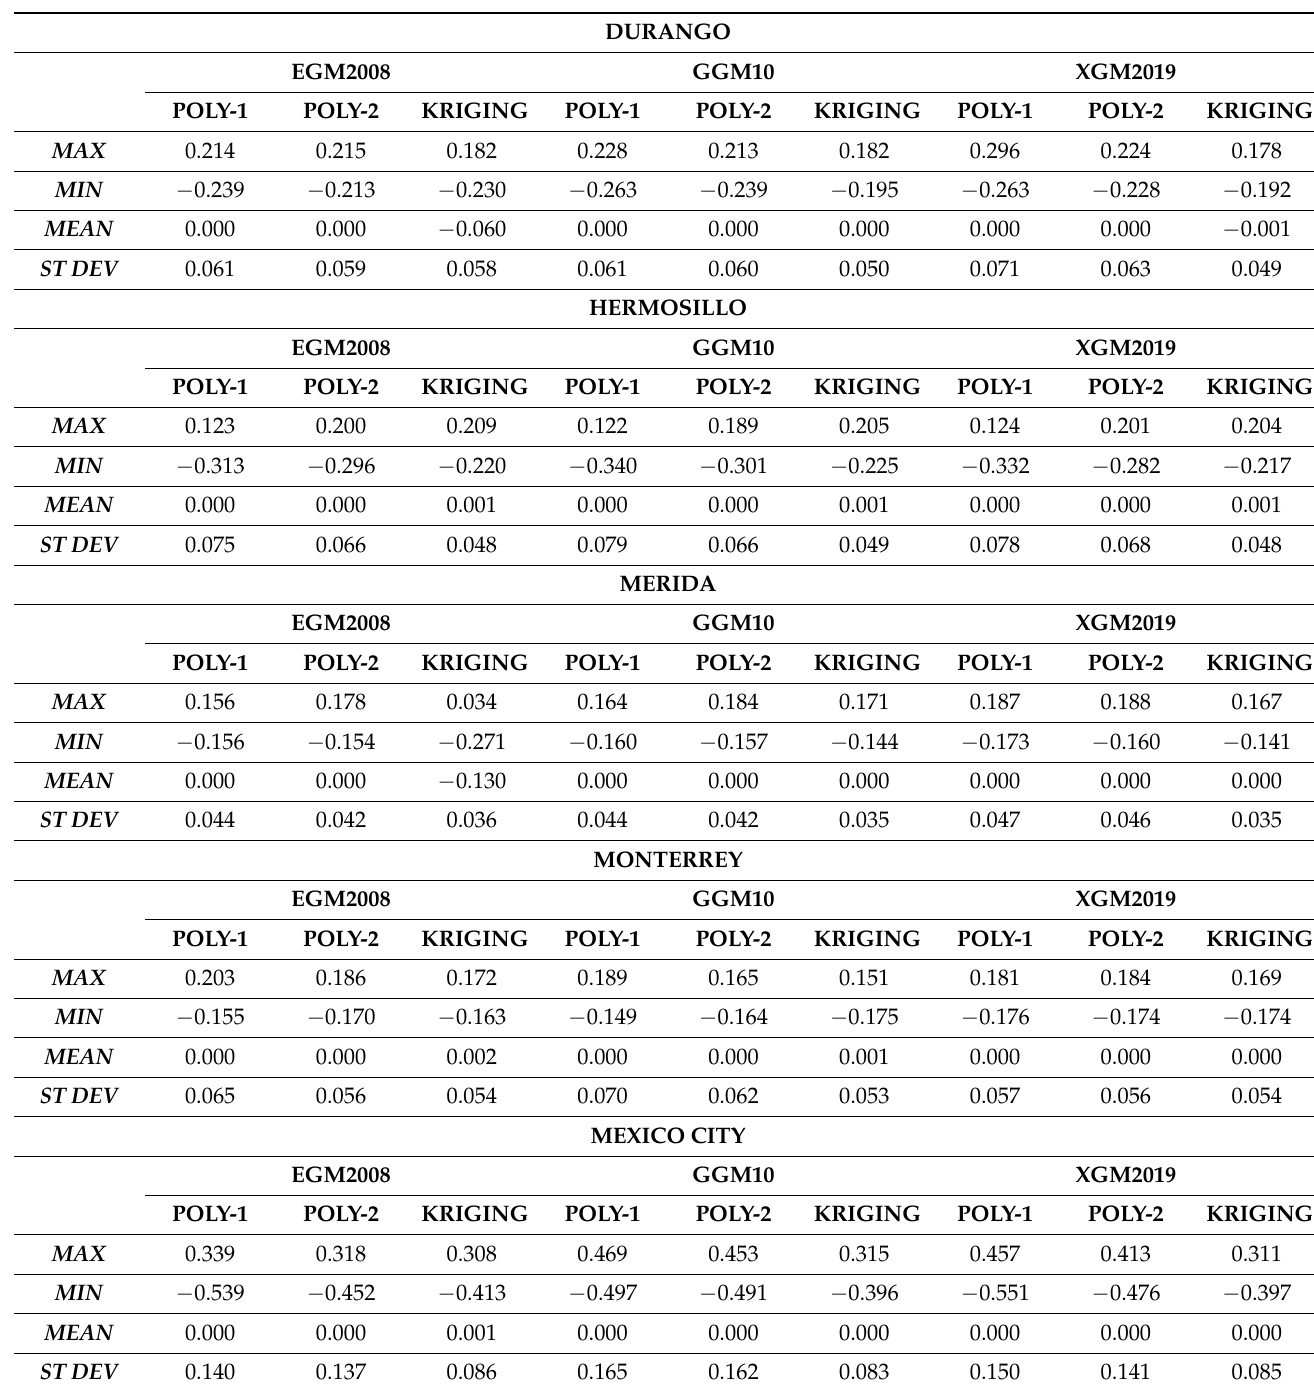
Table 3. Statistics of the corrector surfaces obtained from applying polynomial regressions of order 1, 2, and kriging interpolation to the geoid undulation differences between EGM2008 and GNSS/leveling stations for five Mexican urban areas. Units: